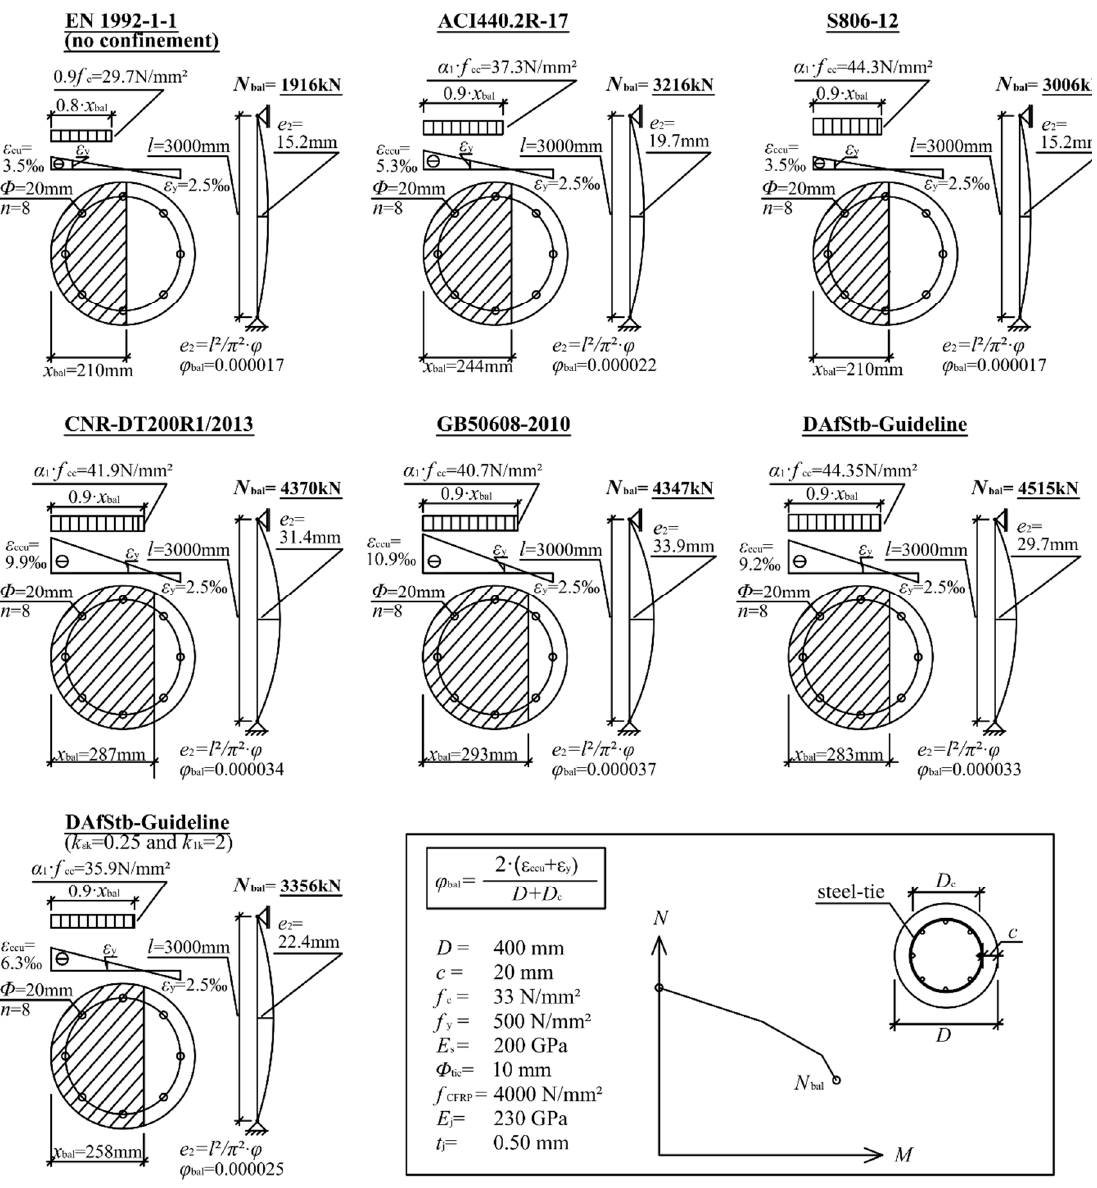
Figure 7. Stress-strain distribution of a CFRP confined RC column at the balance point, according to the considered codes and guidelines.